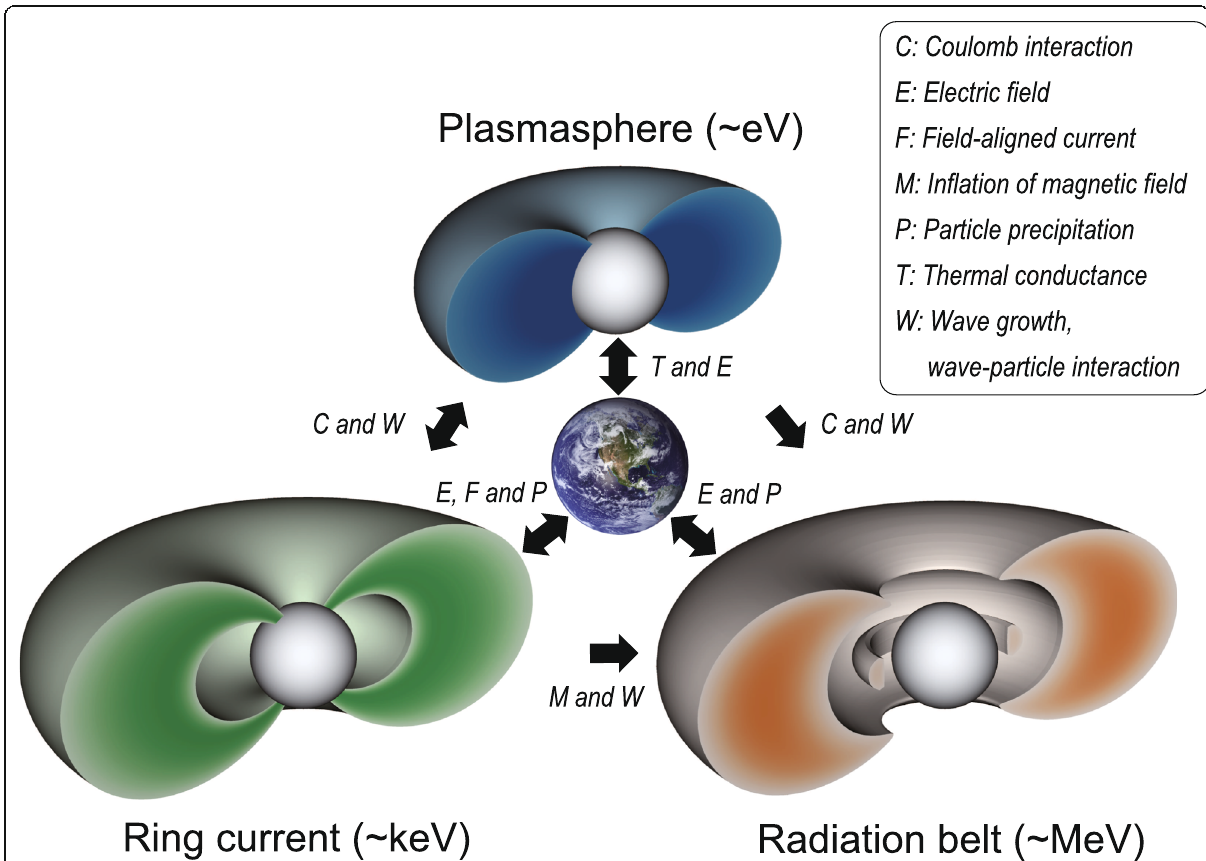
Fig. 15 Cross energy and cross region coupling in the inner magnetosphere and the